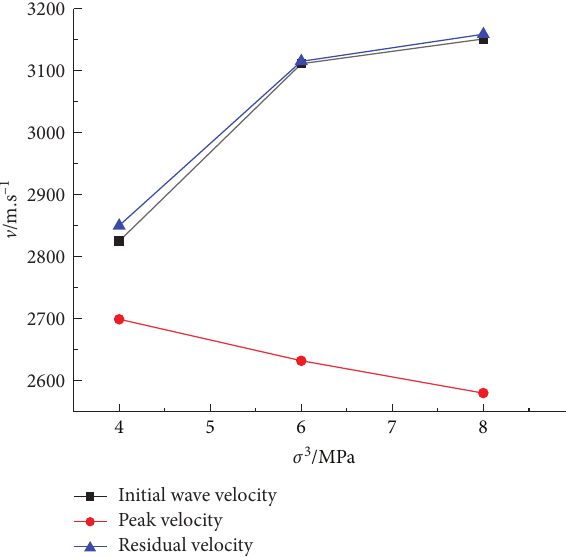
Figure 12: Variations of AW velocity under different initial confining pressures.